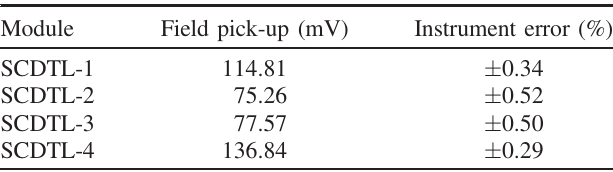
TABLE III. Main rf parameters of the SCDTL structure. Module